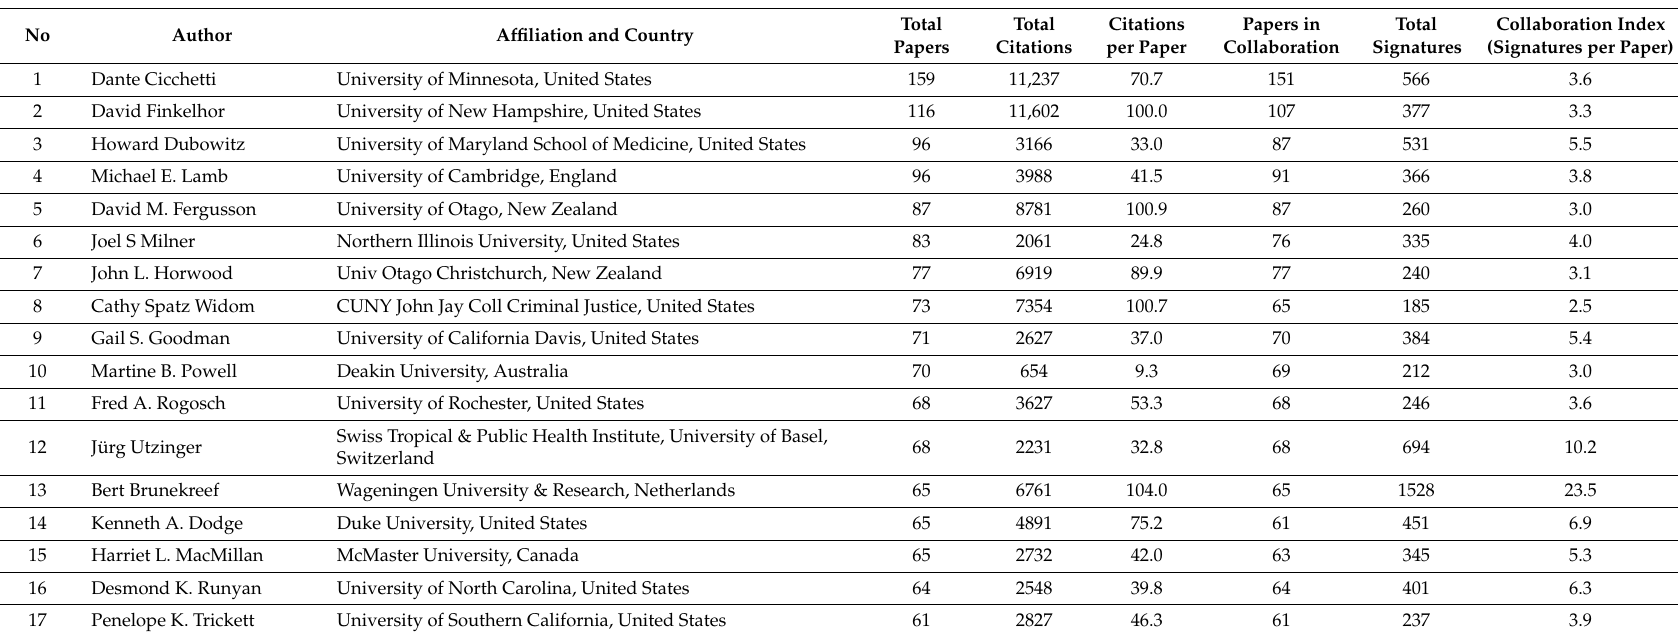
Table 3. Most prolific authors.